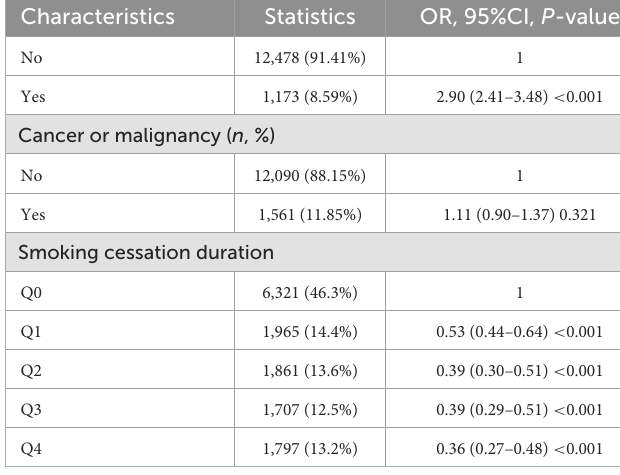
TABLE 8 Univariate analysis of depressive symptoms in the study population based on smoking cessation